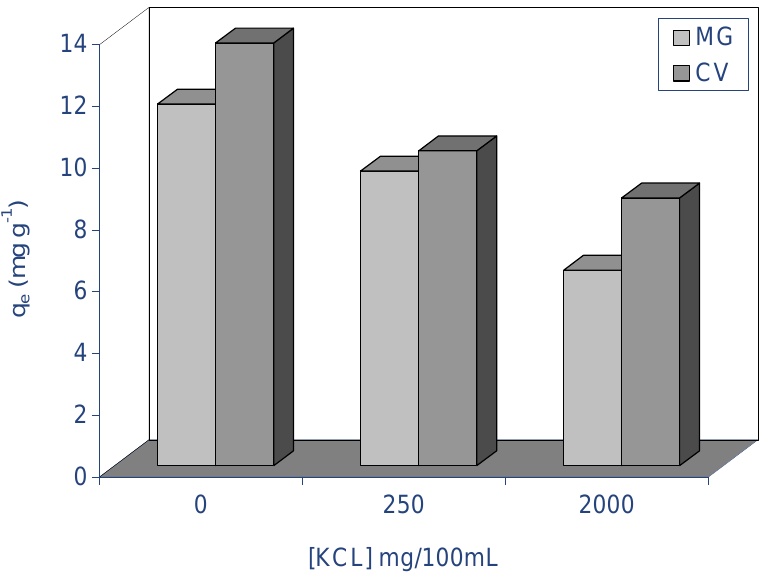
Figure 7. Effect of salt concentration (ionic strength) on the biosorption of MG and CV on ALP (conditions: C 0 : 40 mg/L; biosorbent dosage: 2.5 g/L; stirring speed: 400 rpm; pH (MG): 4, pH (CV): 6.5, T: 298 K).